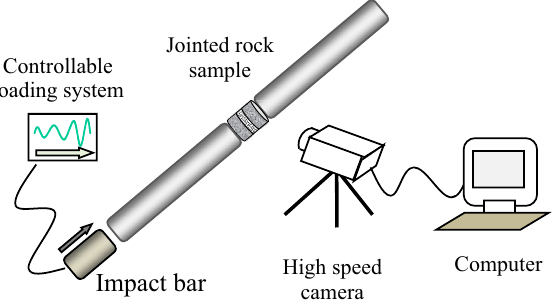
Figure 5. Schematic diagram of SHPB test device with a high speed camera.